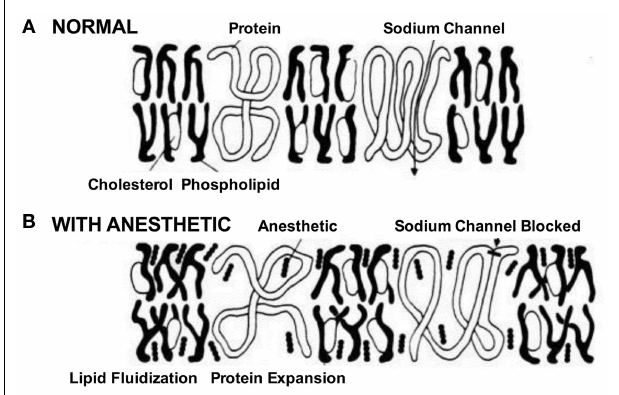
FIGURE 1 | Schematic of the effects of anesthetics on cell membrane and Na + channels. In the absence of the drug. (A) Na + channels initiate and propagate electrical signals, i.e., action potentials. (B) The anesthetic was believed to affect Na + channels by partitioning and interacting with the membrane.This process called lipid fluidification altered the cell membrane and subsequently distorted the channel protein leading to block of channel function (Seeman,